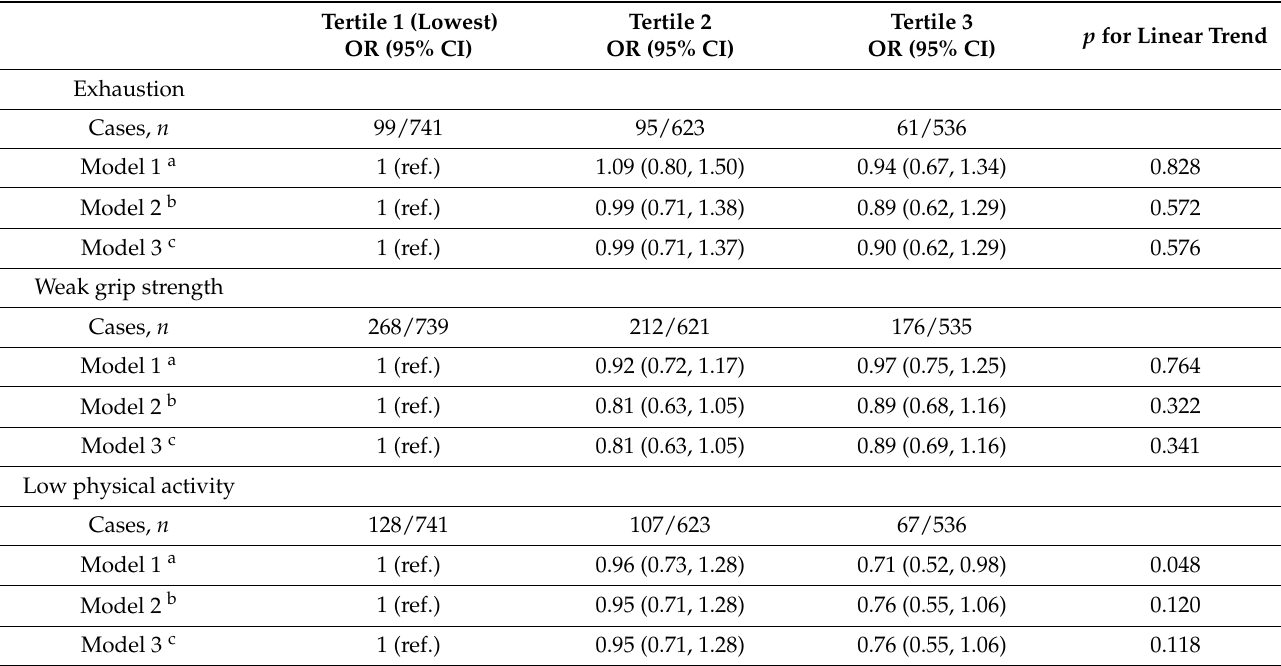
Table 4. Risk of each frailty criterion according to tertiles of adherence to the Healthy Beverage Score in the Seniors-ENRICA-1 cohort ( n =